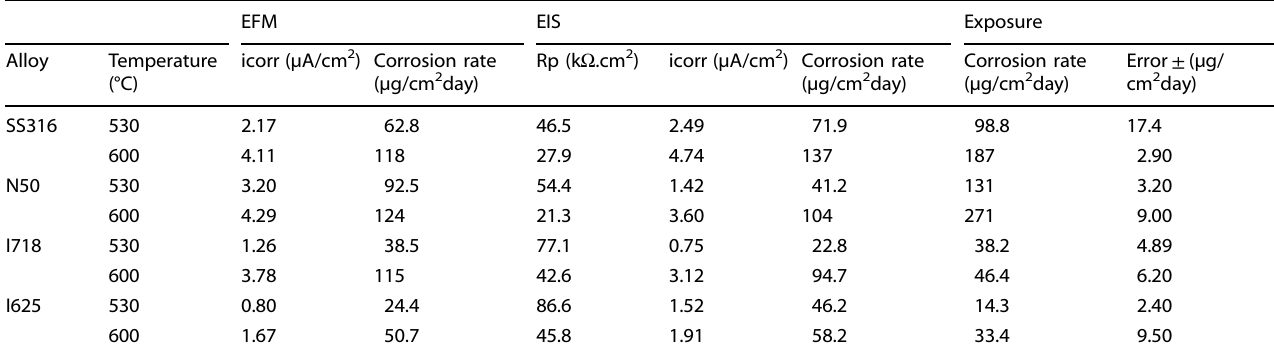
Table 2. Comparison of corrosion rates obtained from electrochemical and gravimetric studies: Corrosion rate values of SS316, N50, I718 and I625 in supercritical and ultra-supercritical water as determined from gravimetric studies, EFM and EIS EFM EIS